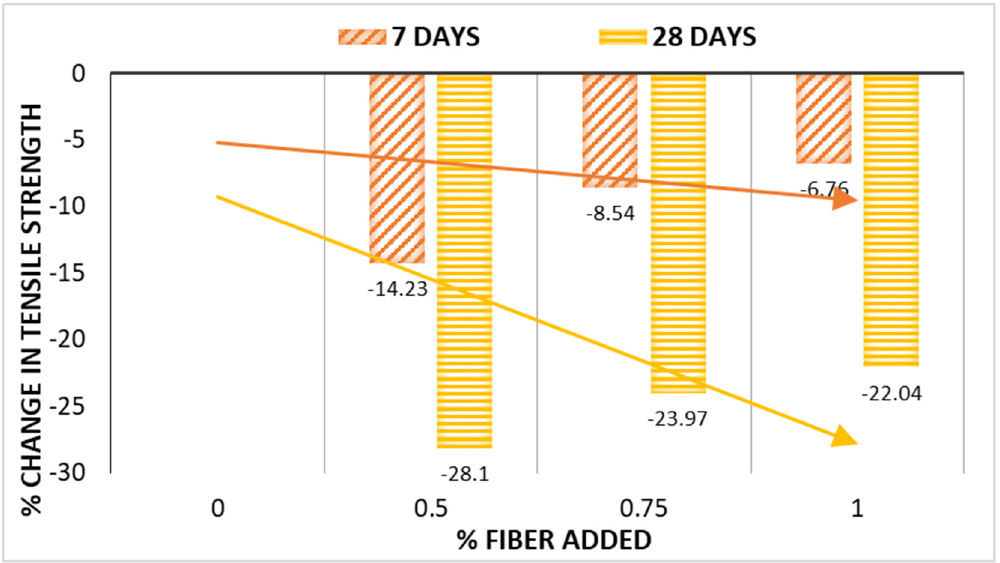
Figure 14. Percentage changes of tensile strength with varying wire percentage.